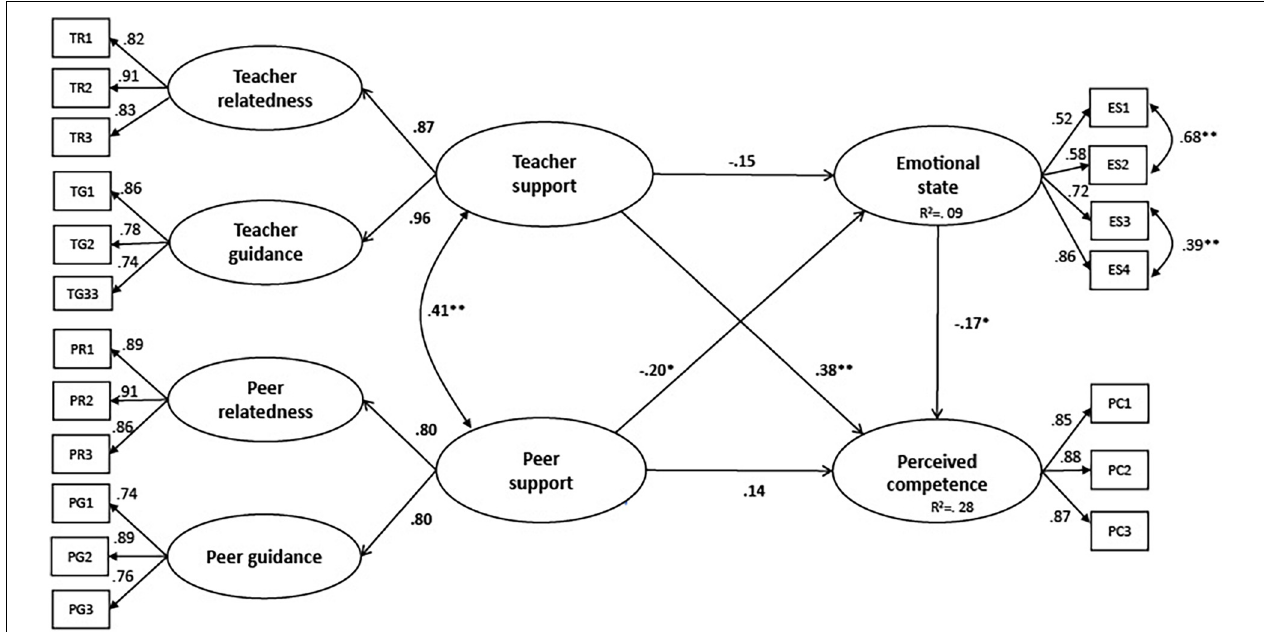
FIGURE 2 | The estimated SEM model. Fit indices: χ 2 = 161.49, p = 0.103, df = 140, χ 2 /df = 1.2, RMSEA = 0.022, p-close = 0.996, CFI = 0.99, TLI = 0.99, SRMR = 0.038. * p -value < 0.05, ** p -value < 0.01.